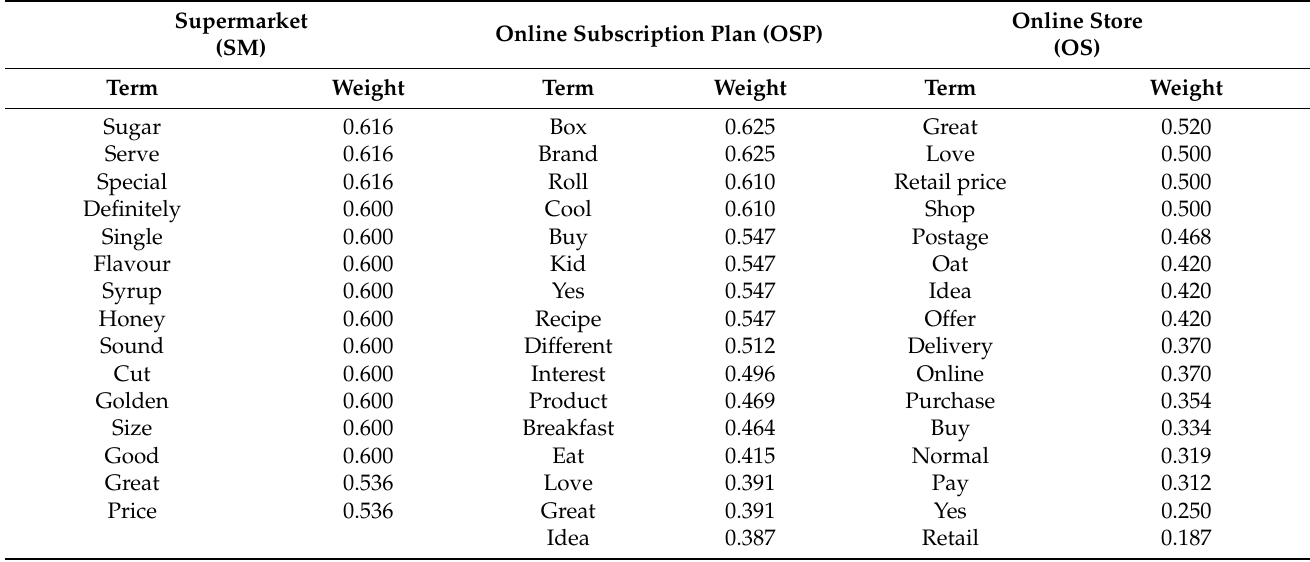
Table 4. Keywords and their weightings.